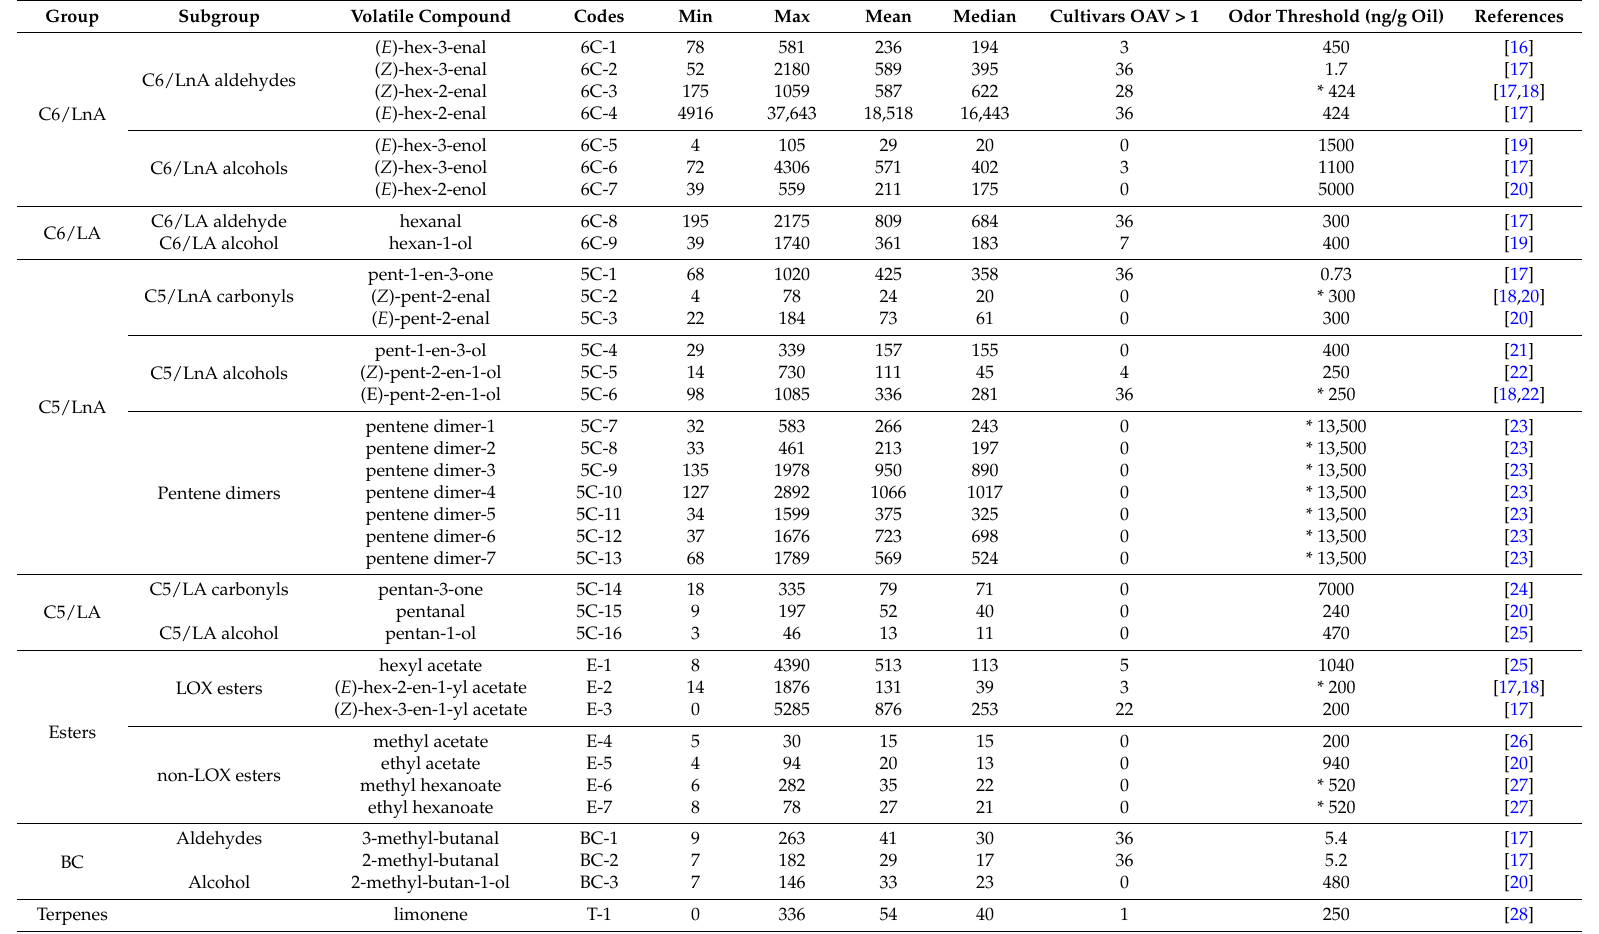
Table 2. Variability and distribution of volatile contents (ng/g oil) in the oils from the WOGC Core-36 accessions. Oils were obtained from fruits at the turning stage, which were hand-picked during years